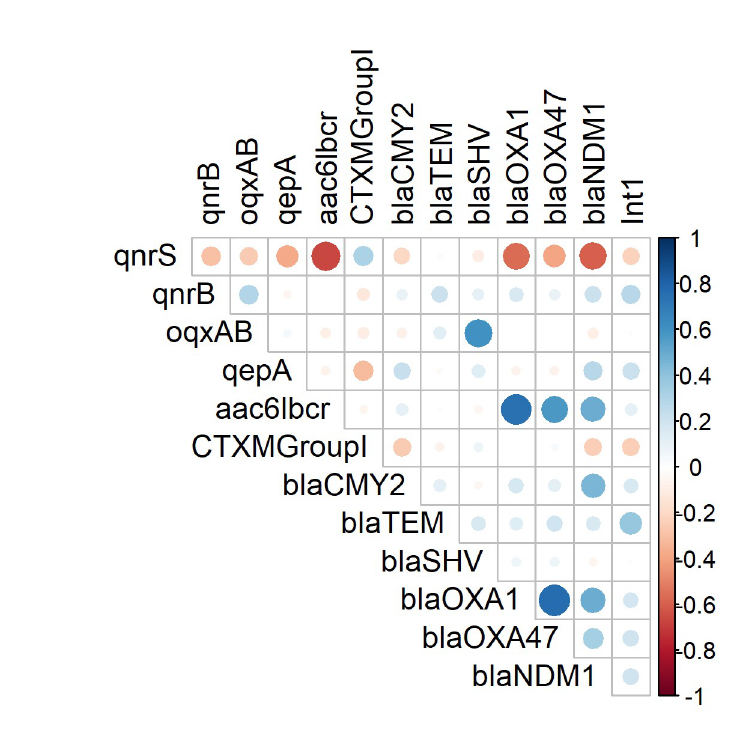
Fig 1. Correlation matrix of the presence of PMQR genes with ESBL and carbapenemase and integron ( int 1) encoding genes in E . coli . White spaces are not significantly correlated. Blue circles indicated significant positive correlation and red showed significant negative correlation. The size and strength of colour represent the numerical value of the Phi correlation